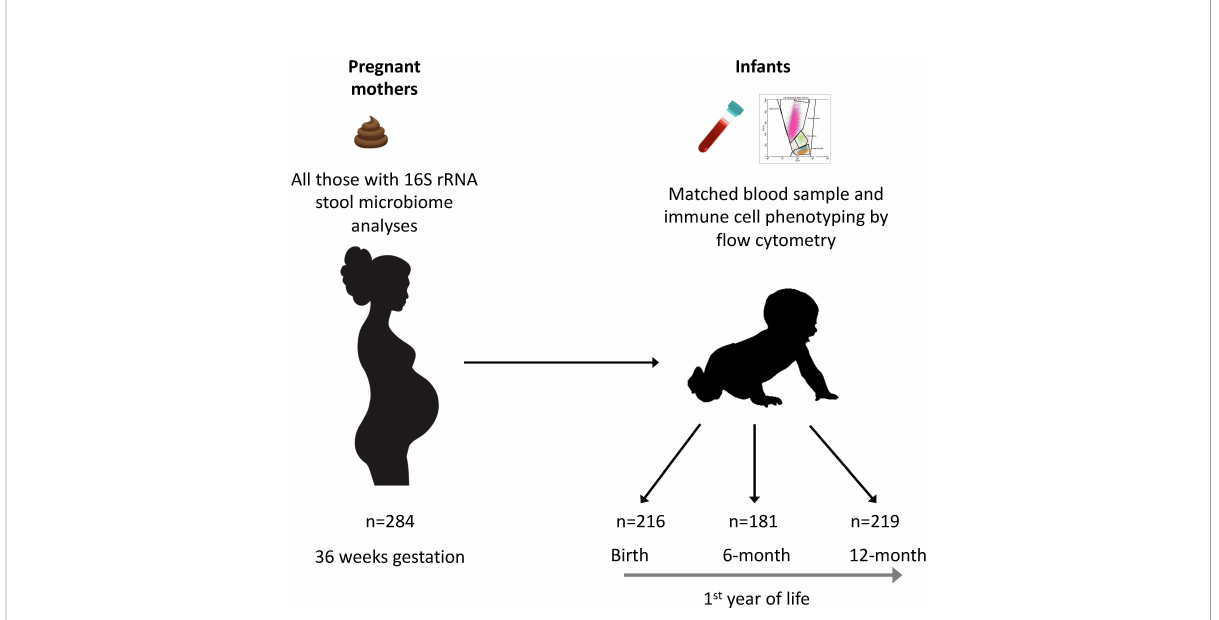
FIGURE 1 Participants and samples included in the study. Fecal samples from 284 mothers were collected at 36 weeks of gestation and the microbiome was analyzed by 16S rRNA gene amplicon sequencing. Cord blood samples from 216 neonates at birth, and peripheral blood samples from 181 infants at 6 months of age and 219 infants at 12 months were analyzed by fl ow